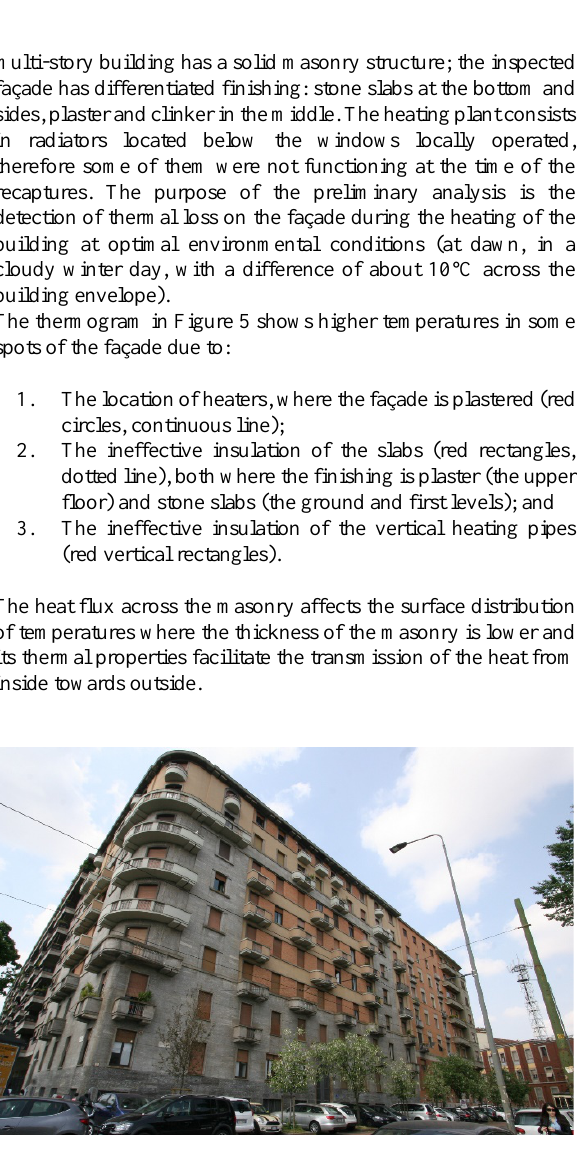
Figure 4 – Eastern façade of the residential building in Piazza